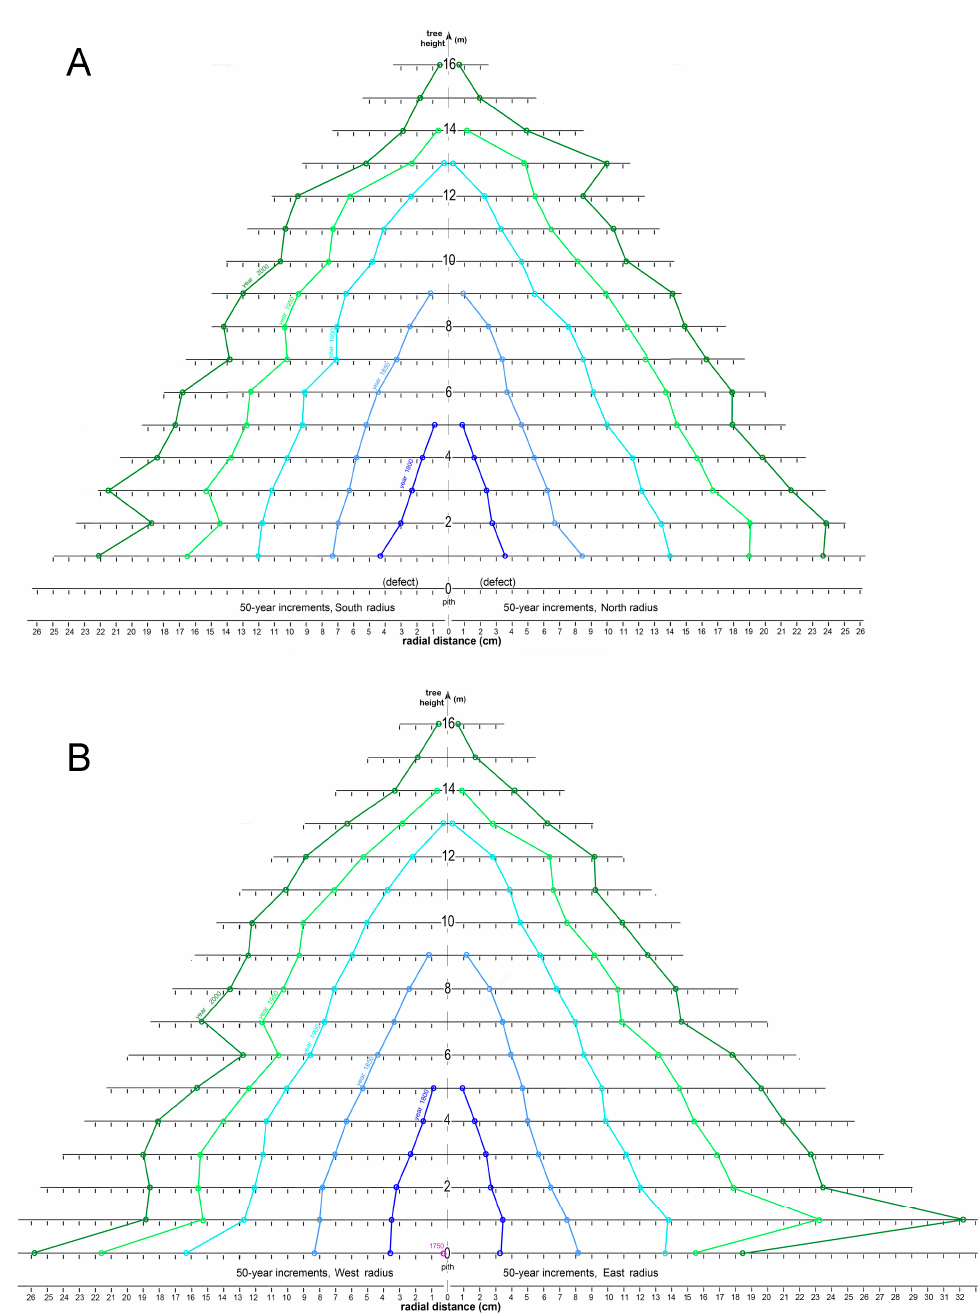
(Figure 18A,B,G). Radially enlarged cambial derivatives were actively maturing into new sieve cells at all trunk positions, and additional radially expanding cells on the periphery of the cambial zone were approaching sieve-cell differentiation.